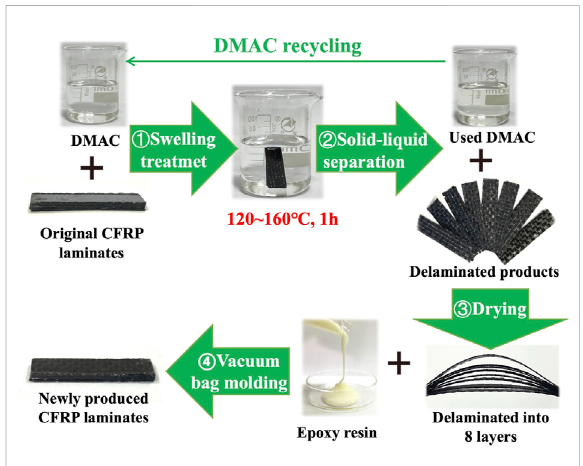
FIGURE 1 Delamination and recycling of the CFRP laminates by DMAC swelling